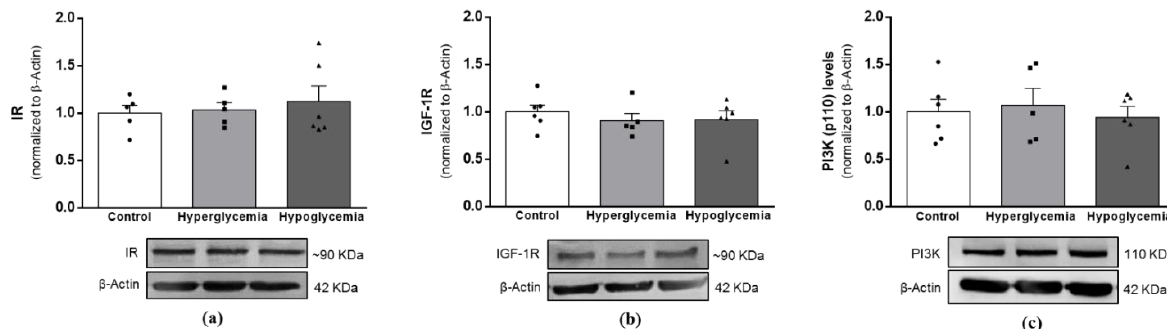
Figure 6. Effects of long-term hyperglycemia and insulin-induced recurrent hypoglycemia on the first steps of insulin signaling. Western blot analyses of ( a ) IR β , ( b ) IGF1R β and ( c ) P13K (p110 α ) protein levels after normalization with β -actin. Bars in graphs represent the mean ± SEM of the quantification of brain cortical samples from 5–6 rats under each condition. Representative immunoblots for β-Actin are shown as the loading control (for uncropped images of the Western blots, please see Supplementary data). IR—Insulin receptor; IGF-1R—Insulin-like growth factor 1 receptor; PI3K (P110)—catalytic subunit of phosphoinositide 3 kinase.